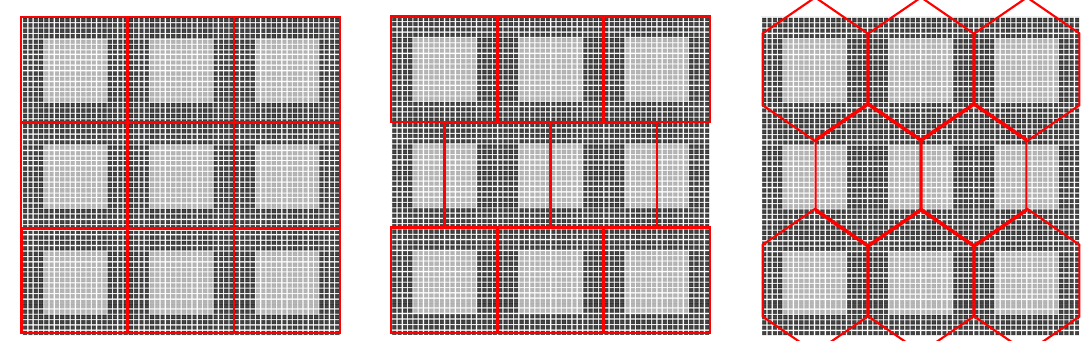
Figure 1 . From left to right: the sensor rearrangement onto the subpixel, the projection of the square pixels onto the hexagonal grid by half pixel shifting method and the projection of the square pixels onto the hexagonal grid in generation of hexagonal image.